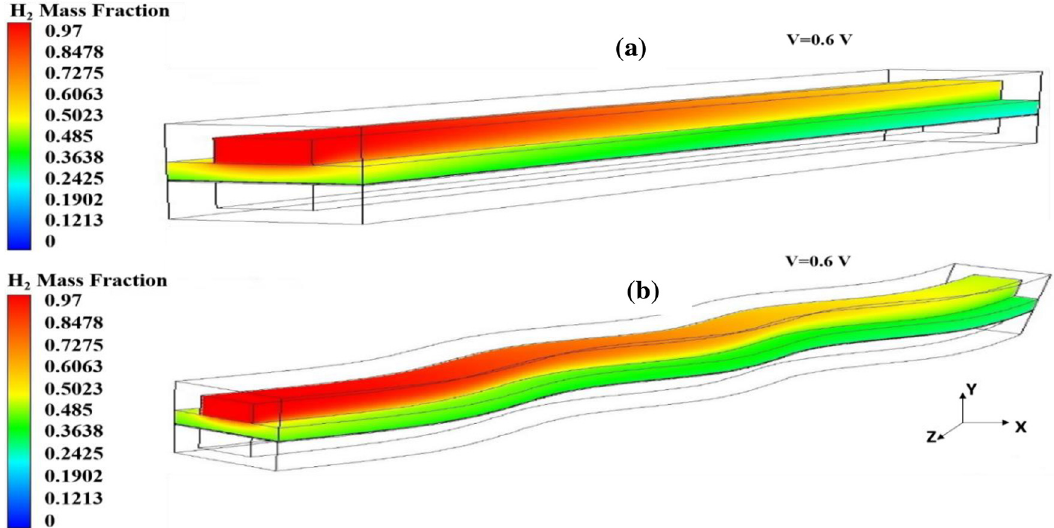
Fig. 4. Hydrogen mass fraction distribution contour along the anode channel for two different fl ow designs at 0.6V.